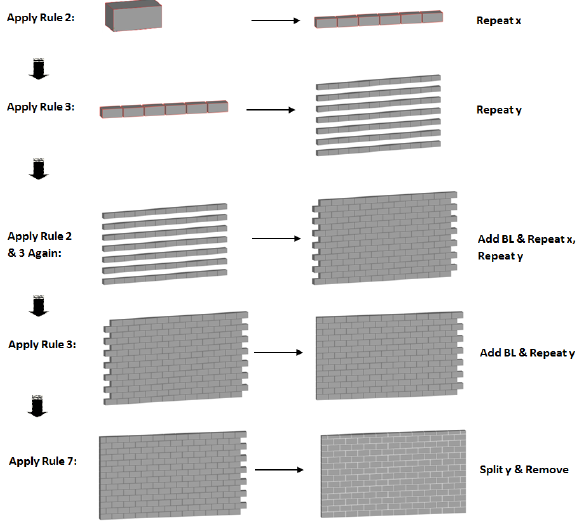
Figure 8. Application of shape rules specified in Table 1.